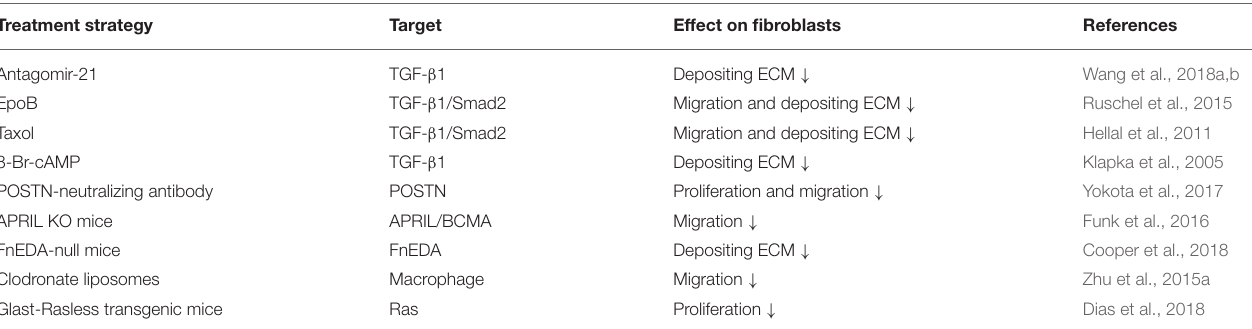
TABLE 1 | Treatments targeting the formation of fibrotic scar after spinal cord injury